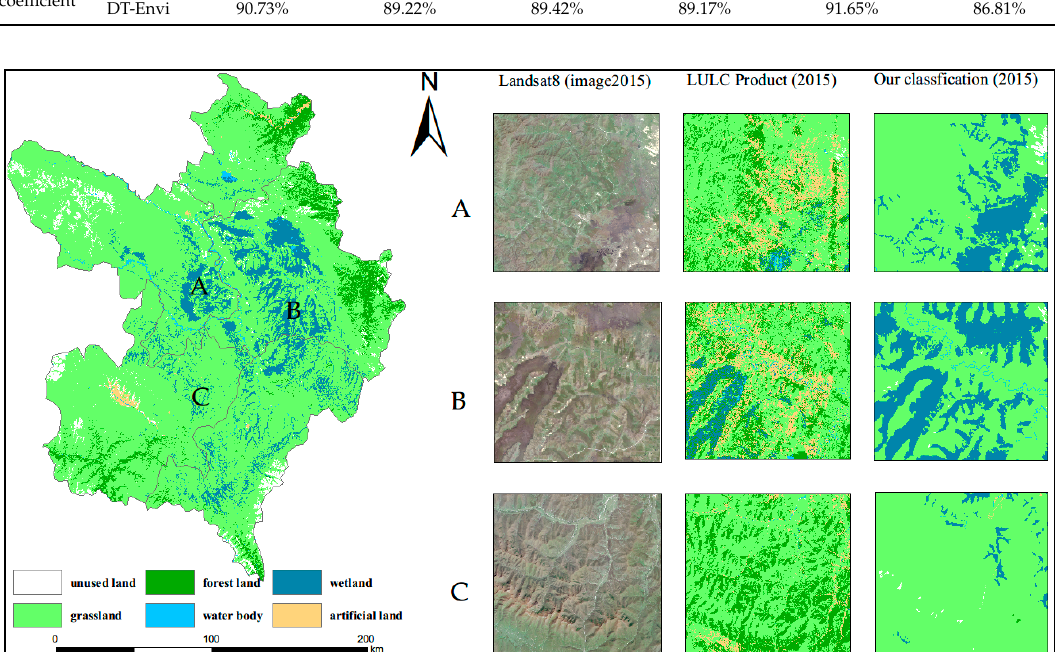
Figure 3. Alpine wetland distribution in ZP for different periods.